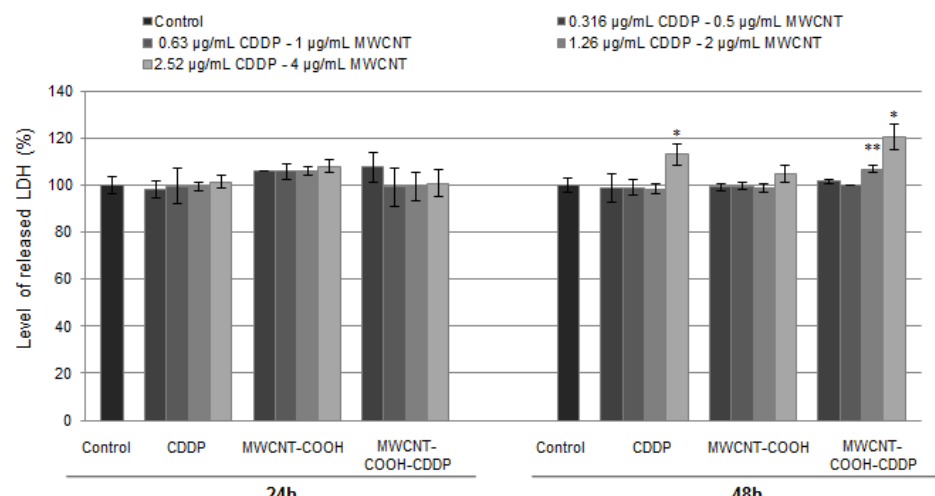
Figure 6. The level of LDH released in culture medium by breast cancer cells after 24 h and 48 h of exposure to various concentrations of MWCNTs (0.5–4 µg/mL) and CDDP (0.316–2.52 µg/mL). The results are calculated as the mean ± SD of 3 replicates and represented relative to control (untreated cells). * p < 0.05, ** p < 0.01 vs. control.